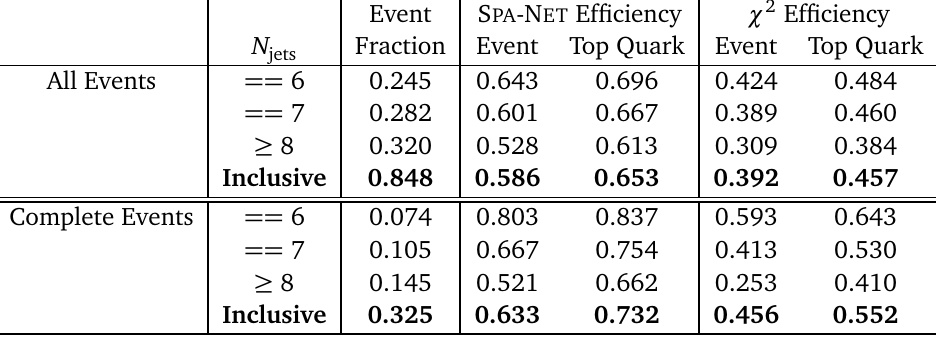
Table 1: Performance on for t ¯ t reconstruction. Complete Events contain all resonance particles fully truth-matched to detected partons. All Events include complete events as well as partial events.